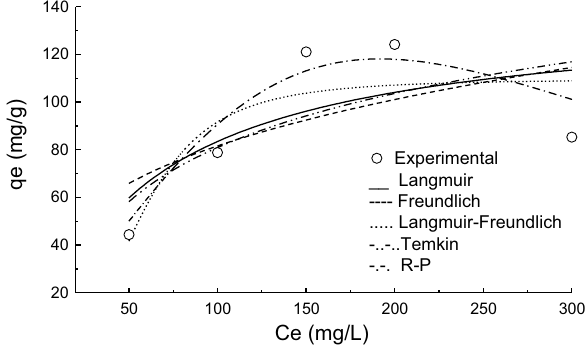
Fig. 8 Isotherm curves for the adsorption of Pb 2+ ions on WM-Fe at 30 °C (initial pH: 6; adsorbent mass: 20 mg; contact time: 0–24